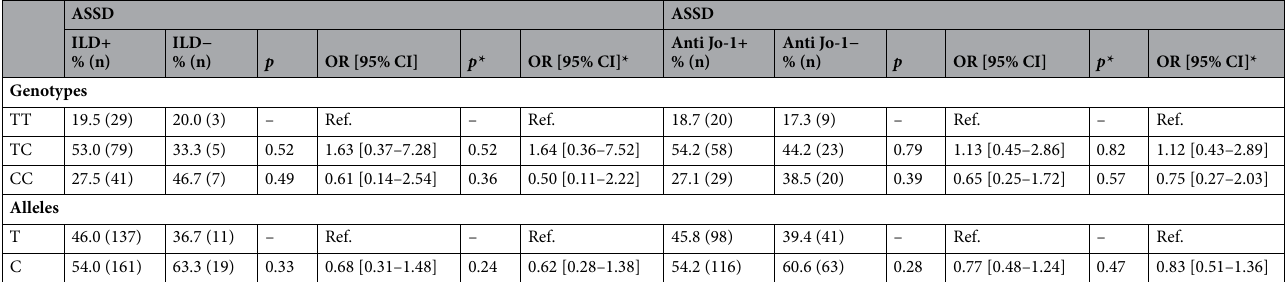
Table 2. Genotype and allele frequencies of MUC1 rs4072037 in patients with ASSD stratified according to the presence/absence of ILD or anti Jo-1 antibodies. ASSD: antisynthetase syndrome; CI: confidence interval; ILD: interstitial lung disease; OR: odds ratio. *Adjusted for age and sex.